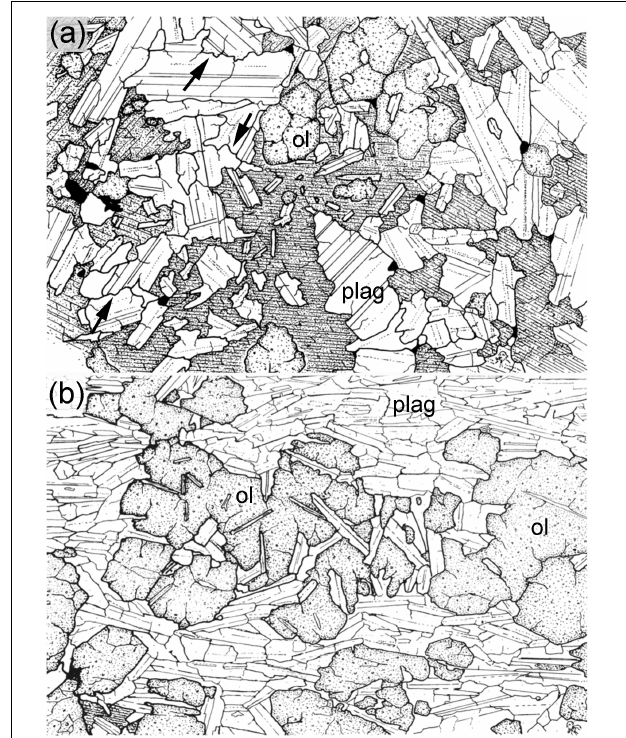
FIGURE 1 | Line drawings of troctolitic cumulates, reproduced with permission from Journal of Geology, from McBirney and Hunter (1995). The cleavage of pyroxene and the twinning of plagioclase are idealized, olivine is stippled and the opaque phase is Fe-Ti oxide. No scale bars were provided in the original drawings, but this absence does not detract from the value of the images, in which the (scale-invariant) grain shape, size distribution, and morphology of grain boundaries are the main points of interest. (a) Troctolitic cumulate from LZa of the Skaergaard, with poikilitic interstitial pyroxene, and a microstructure indicative of in situ nucleation and growth. Note the absence of a shape preferred orientation of the plagioclase, the wide range of grain sizes (pointing to a prolonged period of nucleation, with no hydrodynamic sorting), and the irregular grain boundaries commonly at high angles to expected growth faces typical of growth to impingement (examples are arrowed). In such rocks, minerals commonly have compositional zoning adjacent to interstitial grains (not shown). (b) A troctolite from the Eastern Layered Series of Rum, with the expected microstructure for a crystal mush formed predominantly by the accumulation of crystals grown elsewhere. The strong lamination is defined by a shape preferred orientation of euhedral, unzoned, plagioclase. Grain boundaries are generally planar, formed by juxtaposition of euhedral grains bounded by growth faces. The narrow range of grain sizes is consistent with hydrodynamic sorting. Plagioclase grains enclosed by olivine are generally more elongate and randomly oriented, preserving an early stage of mush